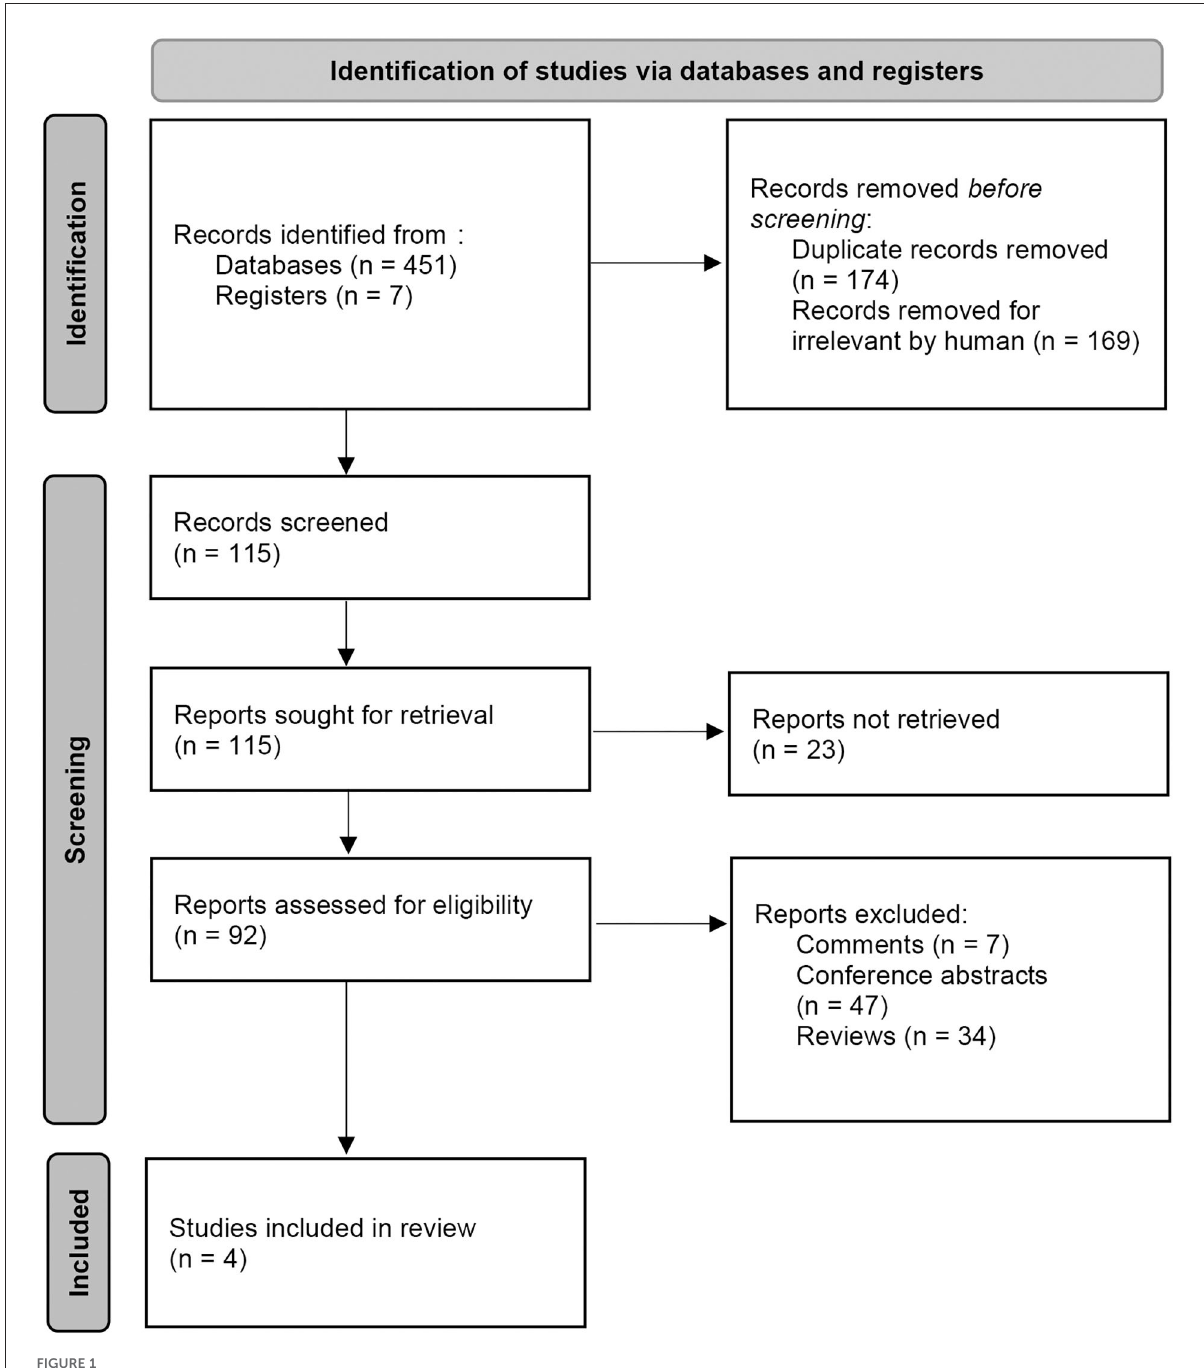
FIGURE1 PRISMA flow gram of the study search, selection, and inclusion process.